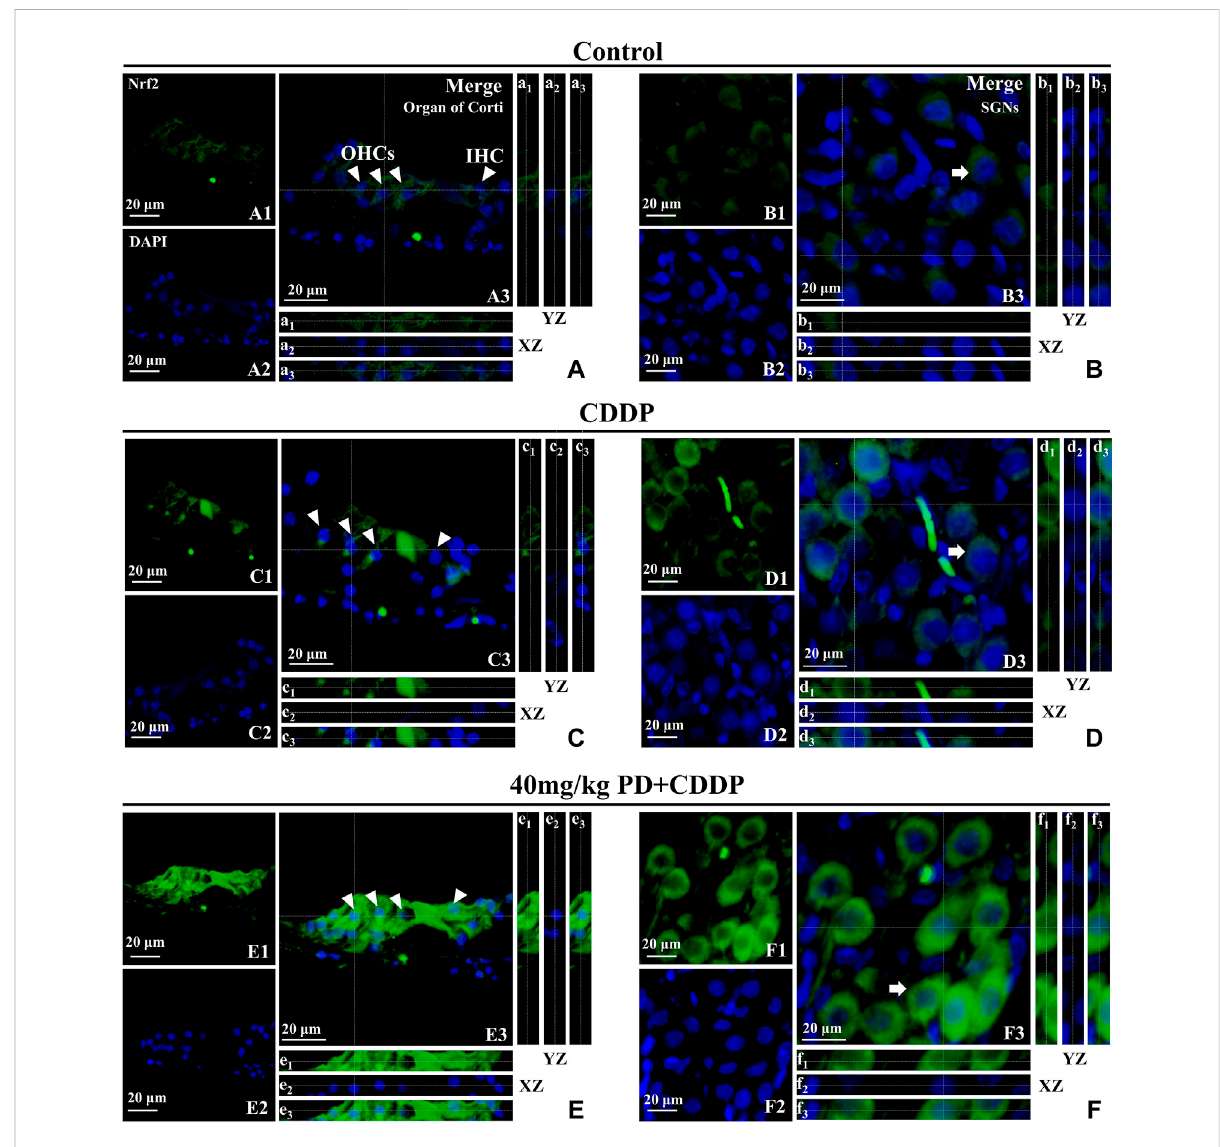
FIGURE 8 PD promotes Nrf2 translocation into the nucleus and increases HO-1 expression. Arrowheads indicate OHCs and IHC; arrows indicate SGNs. (A – F) :representativeimmuno fl uorescencelabellingintheorganofcorti(leftpanel)andSGNs(rightpanel)forNrf2(green),doublestainedwithDAPI in blue. A3-F3 represent the merged images. X – Z and Y – Z cross-sections in boxes (referred to the dashed lines) from the Z-stack acquisitions show cytosolicornuclear fl uorescencesignal(XZandYZboxes,a1-f1:Nrf2 fl uorescence;a2-f2:DAPIstaining;a3-f3:Merge).Cisplatinadministration (C,D) inducedan antioxidant responseinthecochlea,resultinginaslight increase ofNrf2expression inthecytoplasm [XZ andYZ c1-c3 andd1-d3in (C,D) ] compared to the control group [XZ and YZ A1-A3 and B1-B3 in (A,B) ]. After PD administration (E,F) , the expression of Nrf2 was further enhanced in the cytoplasm and Nrf2 translocated to the nucleus [XZ and YZ e1-e3 and f1-f3 in (E,F) ]. Scale bar, (A – F) , 20